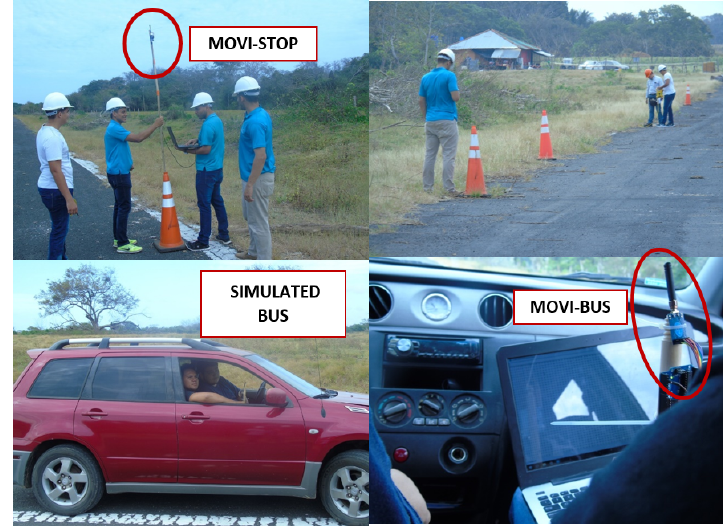
Figure 5. MOVI-BUS–MOVI-STOP field